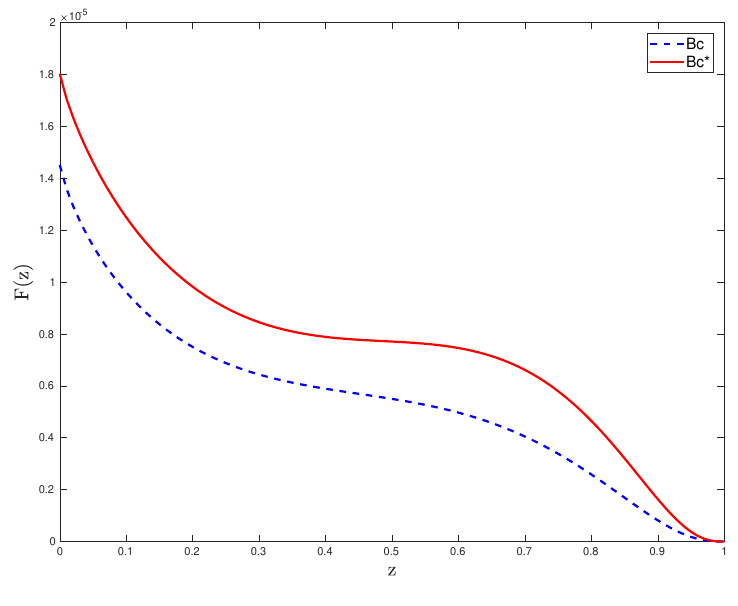
Figure 4 . The coefficients of ln( µ 2 D g → B ∗ ( z, µ F ) , i.e., F ( z ) = α s c